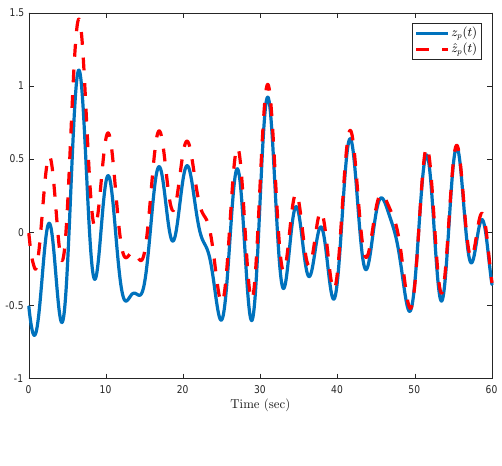
Figure 2. Estimation of the ac- tuator state ˆ z p ( t ) for the ob- server based estimation.